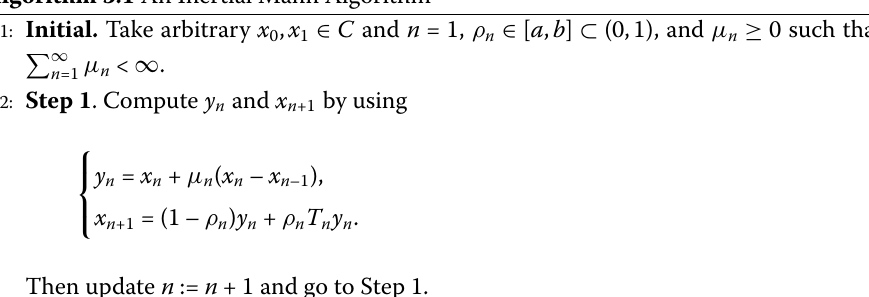
Algorithm 3.1 An Inertial Mann